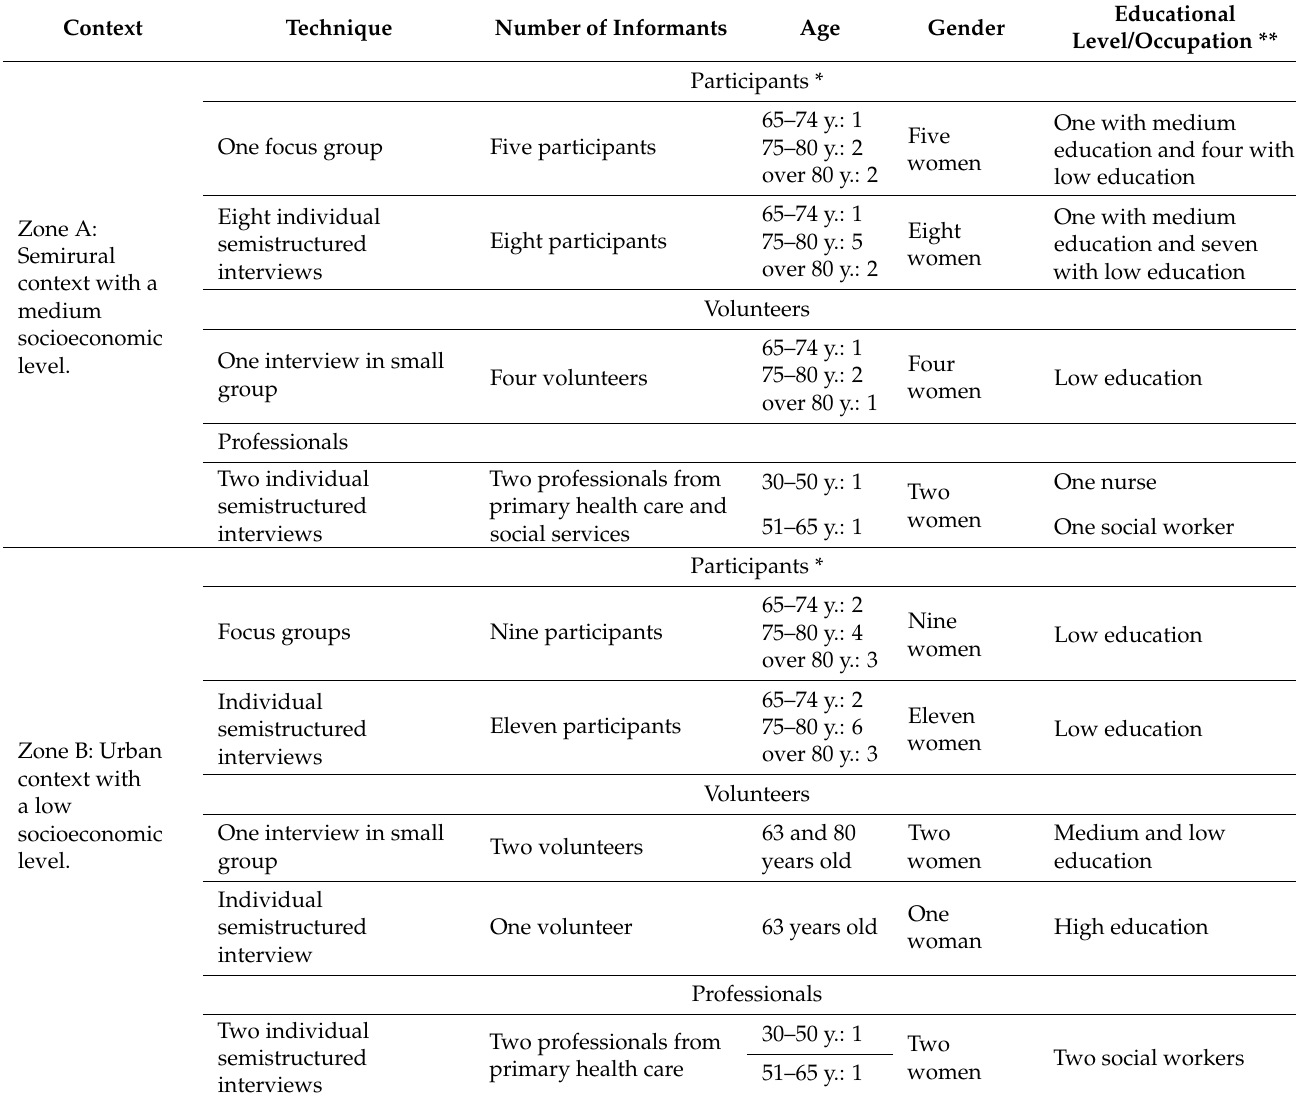
Table 1. Characteristics of participants, volunteers, and professionals